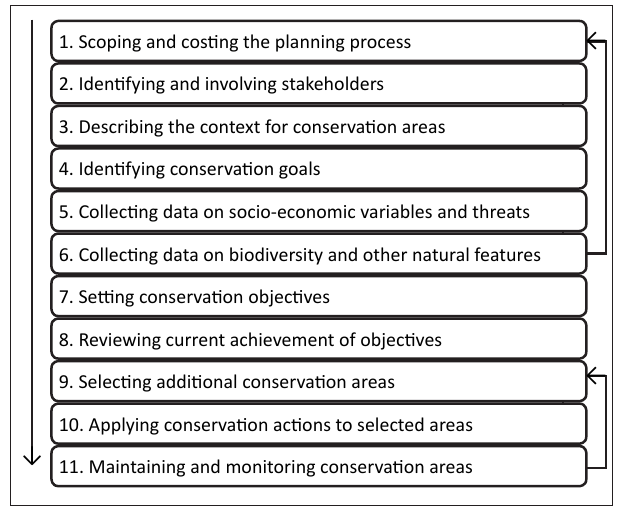
FIGURE 2 : Conceptual framework for systematic conservation planning developed by the IUCN Initiative on Conservation Planning (diagram adapted from Pressey, R.L. & Bottrill, M., 2009, ‘Approaches to landscape- and seascape- scale conservation planning: convergence, contrasts and challenges’, Oryx 43(4), 464–475.